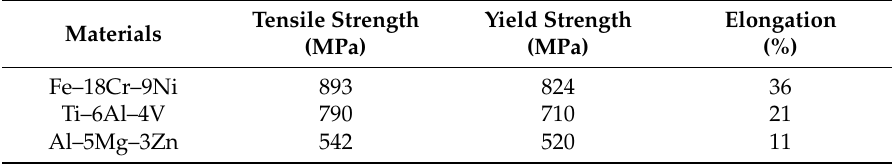
Table 2. The mechanical properties of the three network